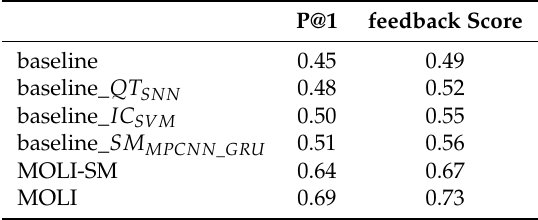
Table 8. End-to-end